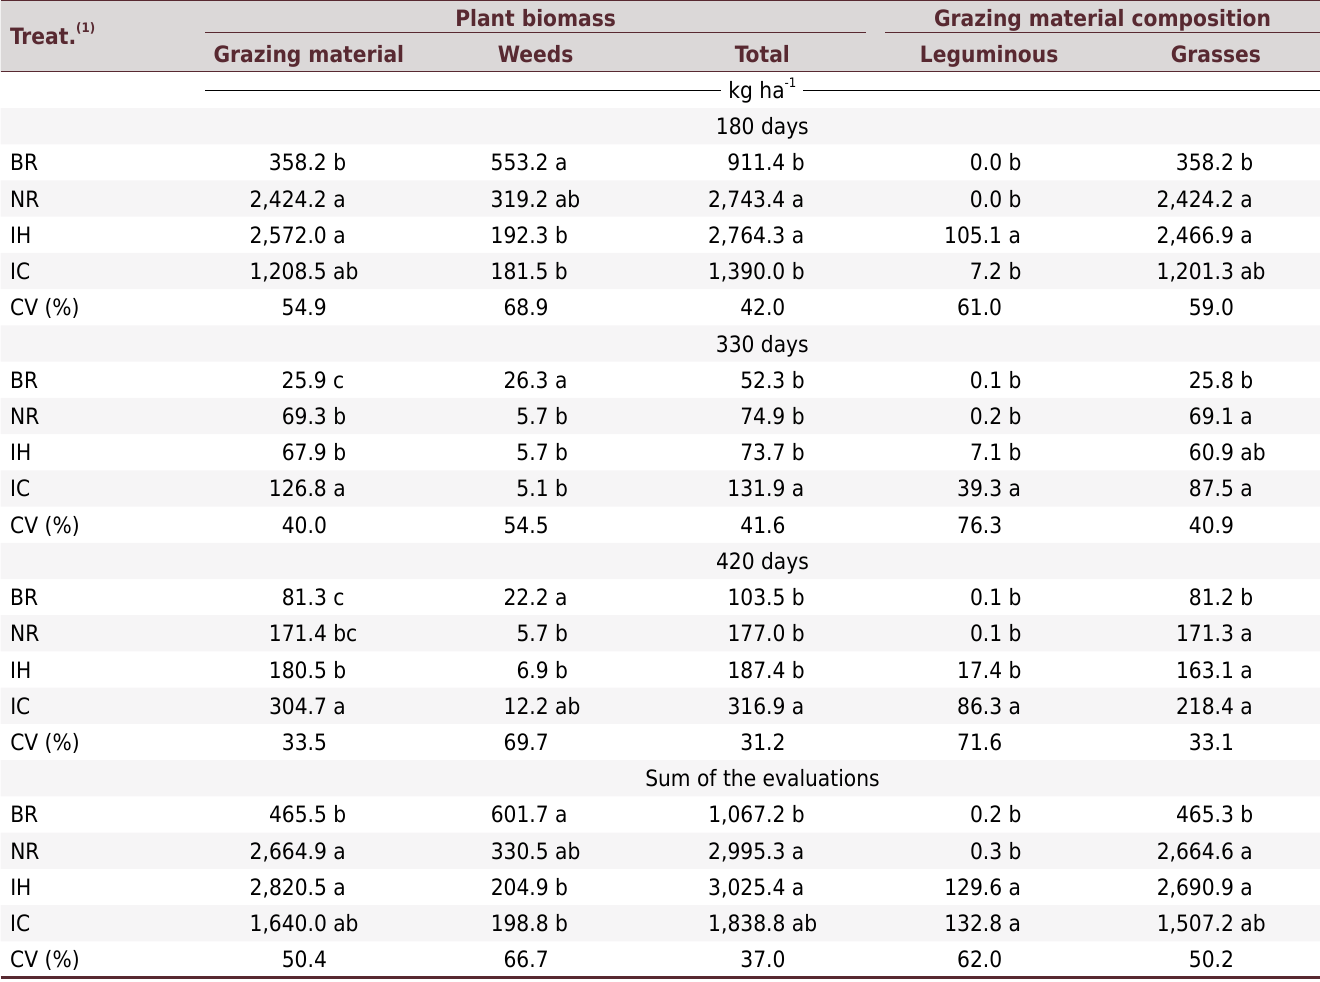
Table 3. Production of plant biomass of grazing material, weeds, and total dry matter, and the composition of leguminous plants and grasses in the grazing material for different treatments and evaluation periods Treat.